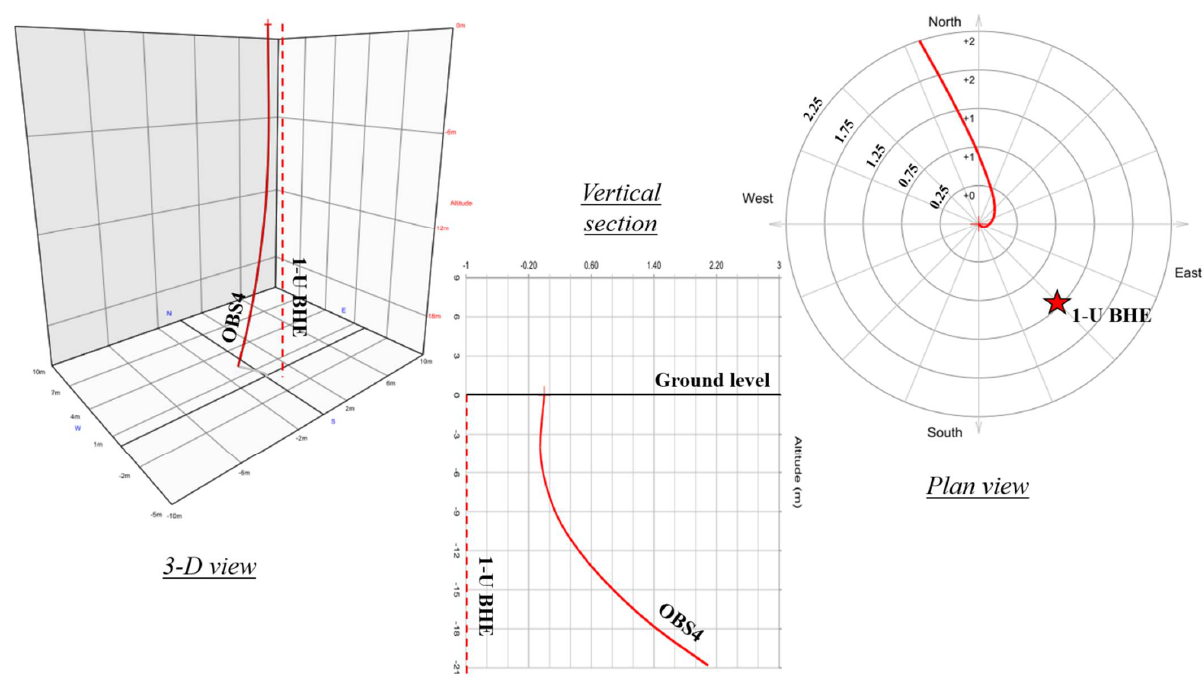
Figure 5. Inclination of the observation well OBS4 (red line) and comparison with the projection of the 1-U BHE (red dashed line and star).